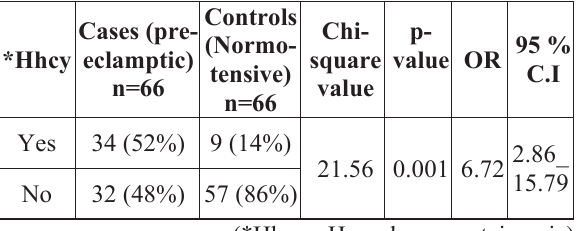
Table-3: Association between Preeclampsia and Hyperhomocysteinemia